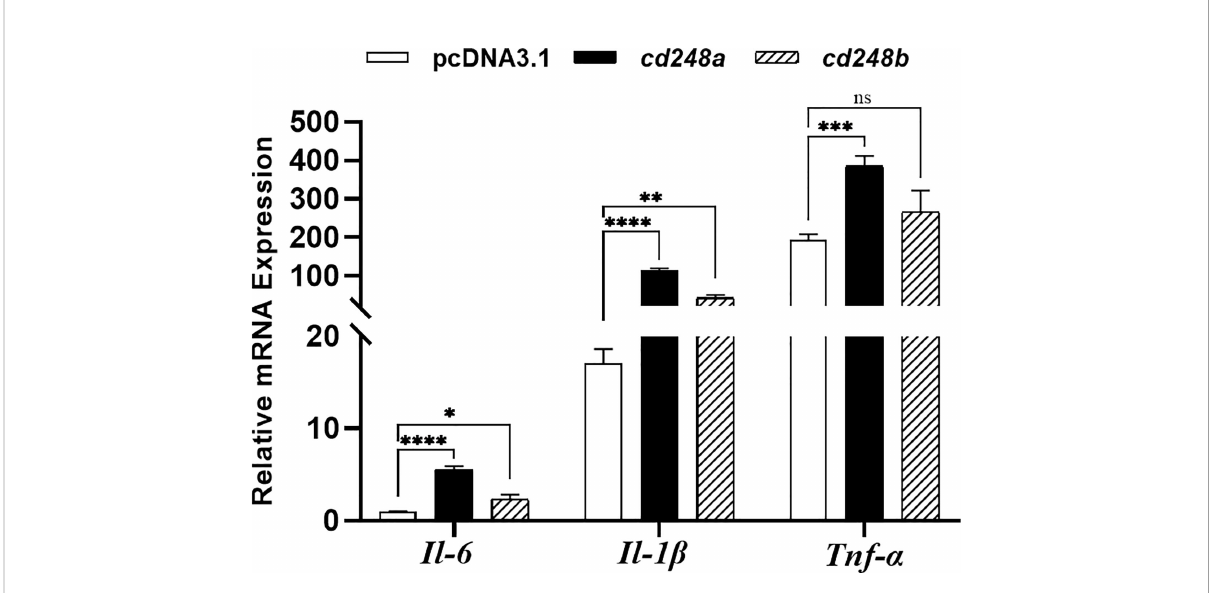
FIGURE 8 Effect of overexpression of zebra fi sh cd248a and cd248b on pro-in fl ammatory cytokines expression in mouse macrophages. The pcDNA3.1/V5/ Cd248a, pcDNA3.1/V5/Cd248b and pcDNA3.1/V5-His A recombinant plasmids were transfected individually into RAW264.7 cells. At 24h